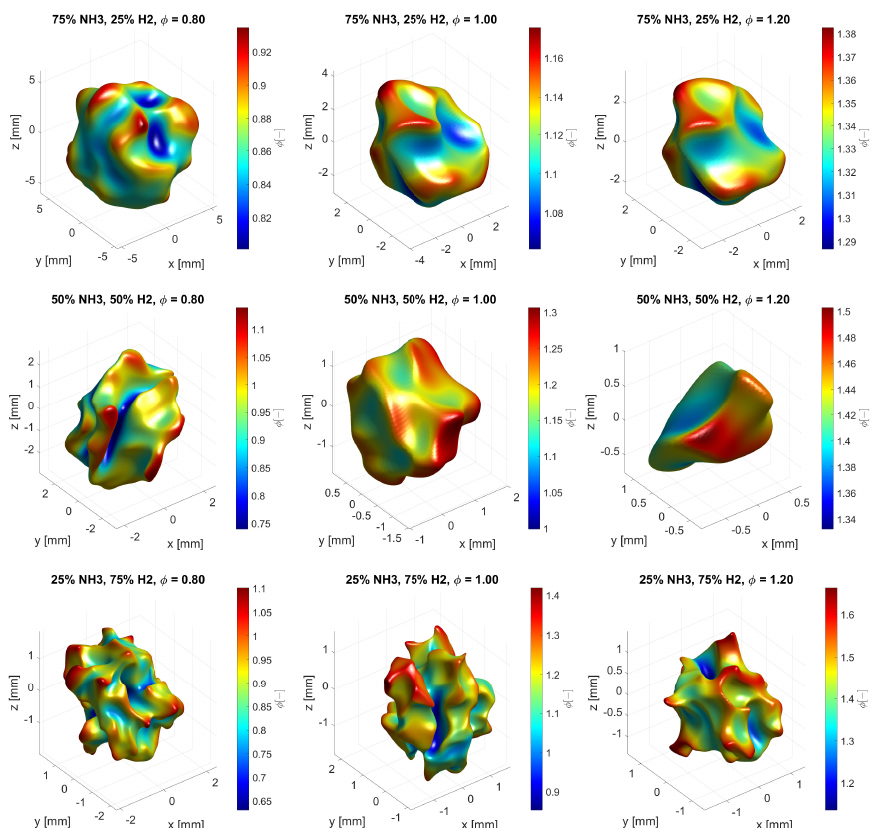
Figure 4. Iso-surfaces of the flame kernel taken after one eddy turnover time, coloured with local equivalence ratio. Significant deviation from the global equivalence ratio can be seen from this